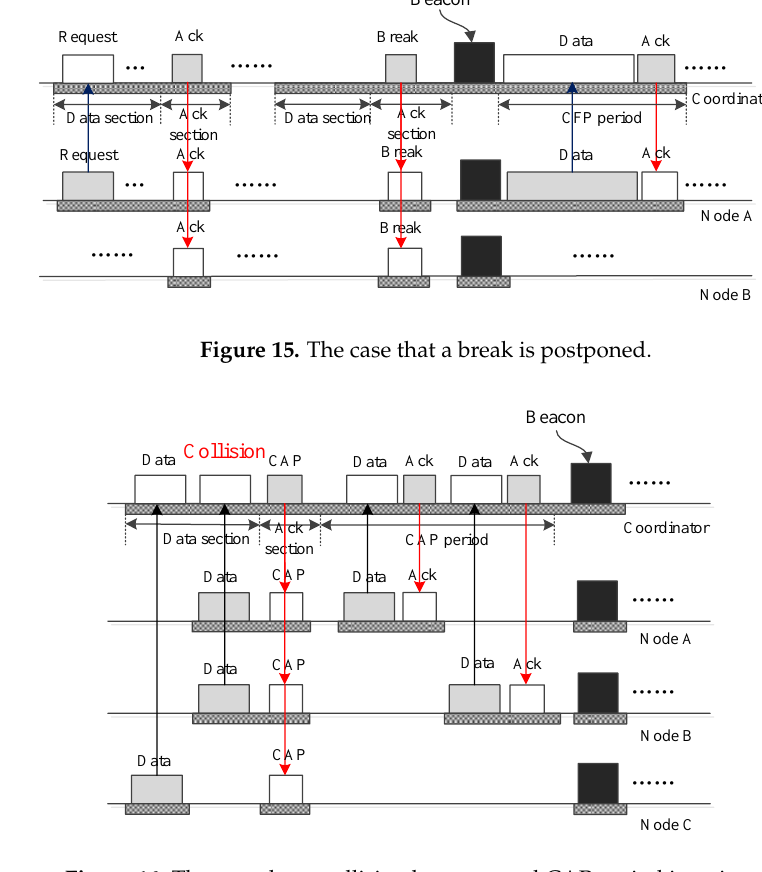
Figure 16. The case that a collision happens and CAP period is